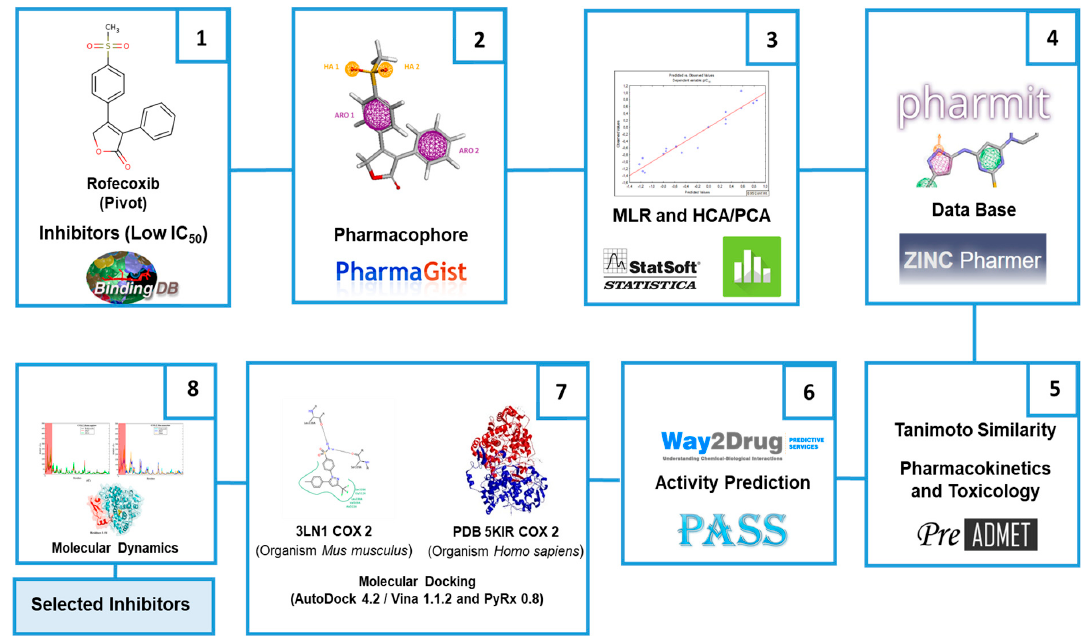
Figure 2. General scheme summarizing of the methodological steps.